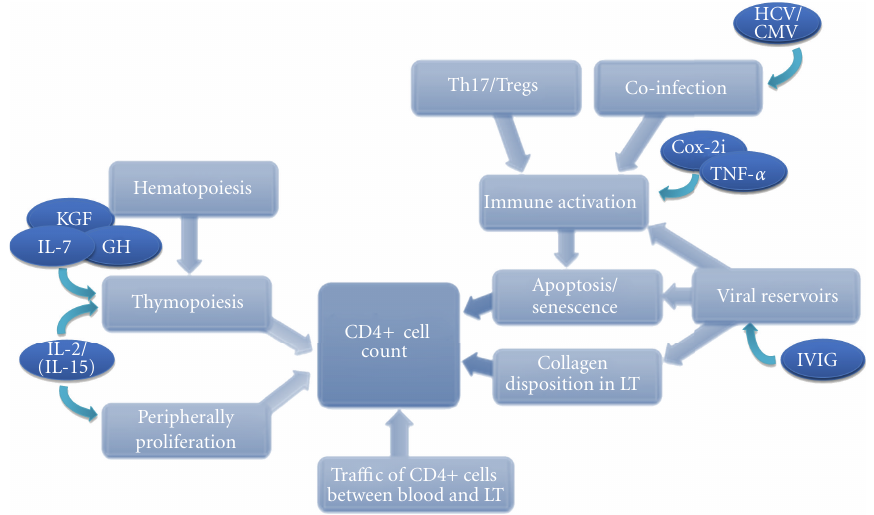
Figure 2: Therapeutical possibilities improving immune reconstitution. KGF: keratinocyte growth factor; IL: interleukin; GH: growth hormone; HCV/CMV: treatment of hepatitis C virus and cytomegalovirus; Cox2i: cyclooxygenase inhibitor; TNF: tumor necrosis factor; IVIG: intravenous